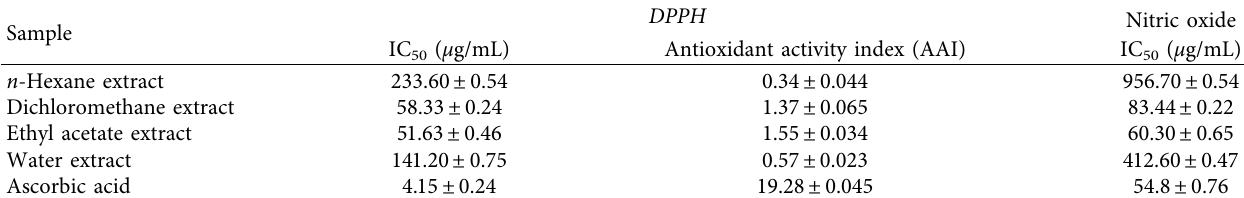
Table 1: Te IC 50 values of various extracts of S. palustris (Burm.f.) Bedd. in DPPH and nitric oxide scavenging